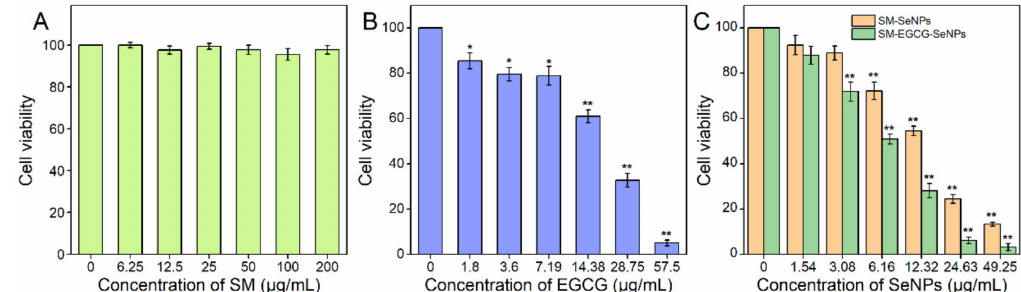
Figure 3. Antiproliferative effect of ( A ) SM, ( B ) EGCG, ( C ) SM-SeNPs and SM-EGCG-SeNPs. Each value represents the mean ± SD. The difference between groups is indicated at * p < 0.05 and ** p <